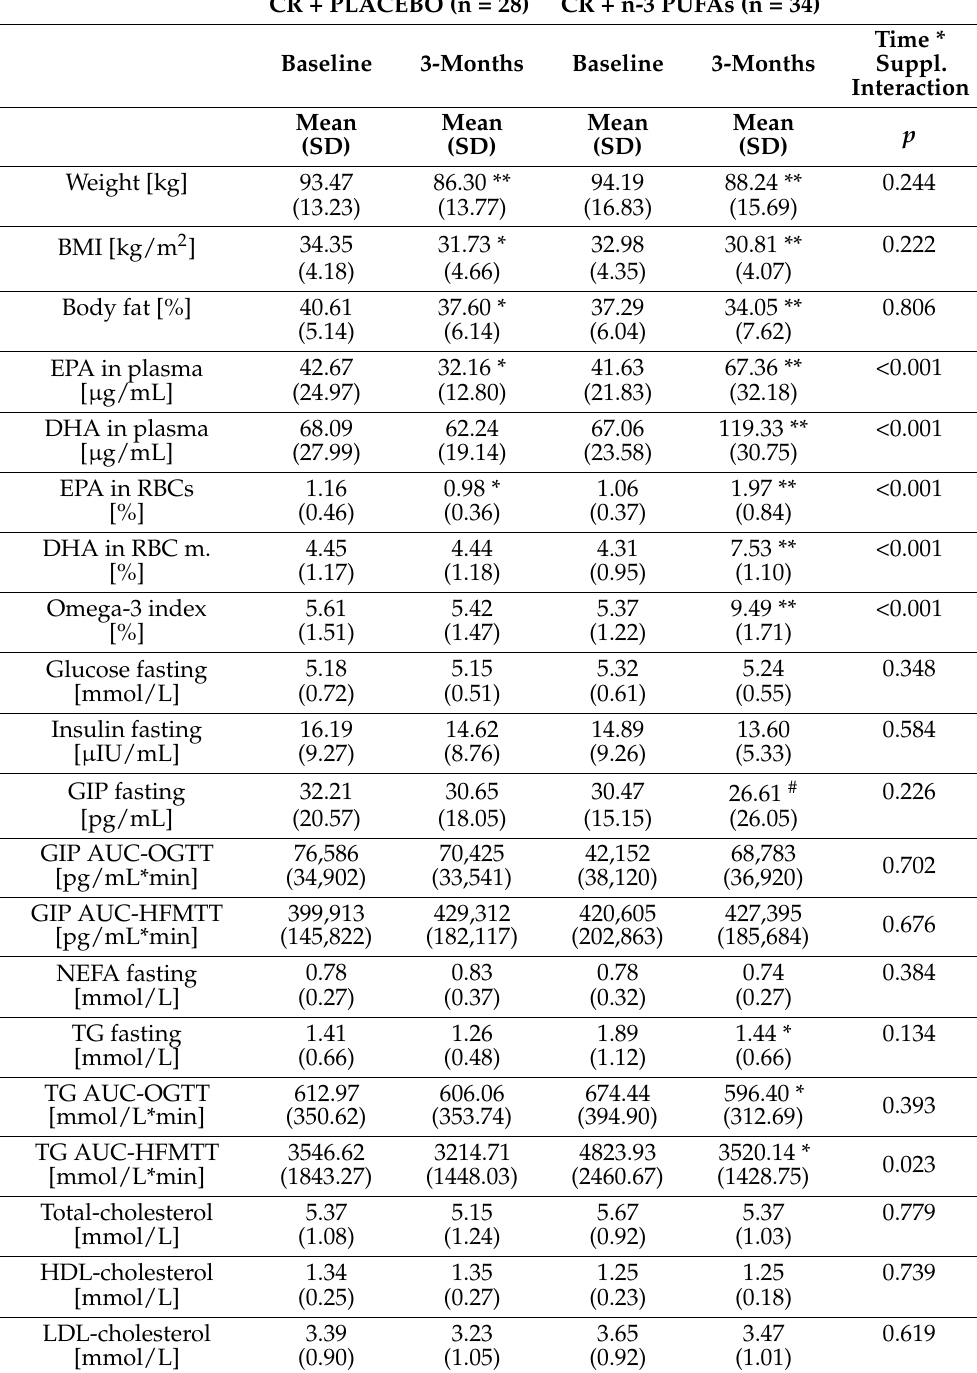
Data are presented as mean (SD); ANOVA for repeated measurements with Bonferroni post-hoc test were used for analysis of supplementation effects by time and group (suppl. placebo vs. n-3PUFA) interaction; *